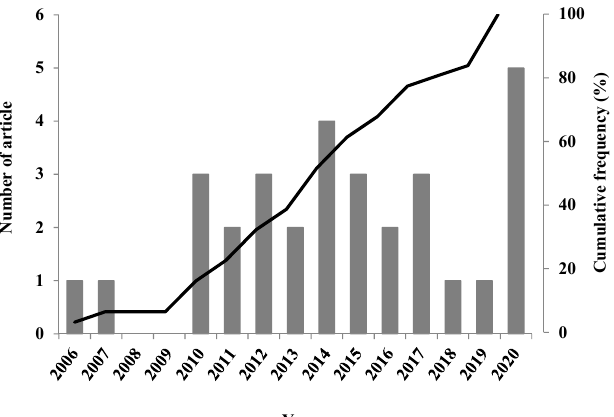
Figure 2. Evolution during the time of the included scientific articles ( n = 31). Bars: Time course of publications showing absolute numbers; Line: Cumulative frequency.